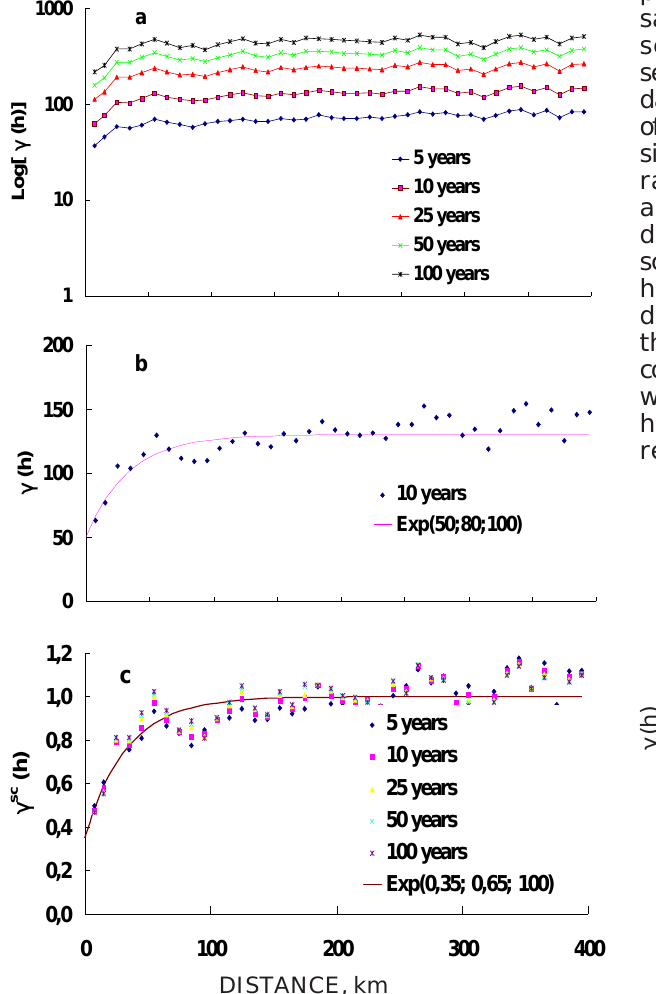
Figure 2. Individual semivariograms for chemical properties at 0-0,25 m in Oxisol, Campinas SP, Brazil. a) Base saturation; b) Cation exchange capacity; c) Sum of bases; d) Delta